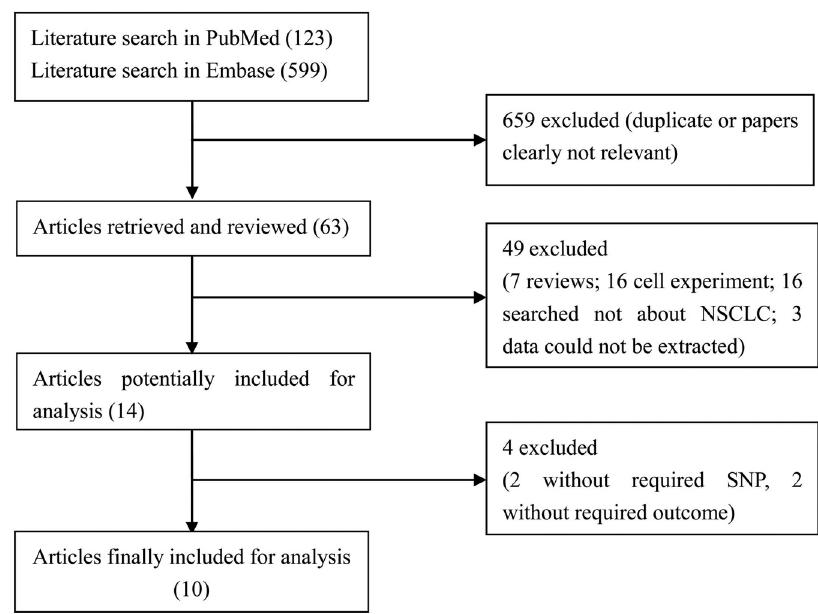
Figure 1 - Flow chart of literature search and study selection.